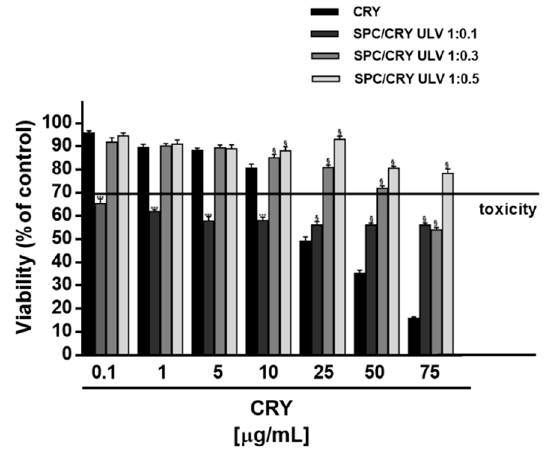
Figure 5. Cytotoxicity of SPC ULV differently loaded with CRY (1:0.1, 1:0.3 and 1:0.5 mol/mol) in MDA-MB-468 cells after 24 h incubation. *** p < 0.001 vs. CRY, denotes a statistically significant increase of cytotoxicity respect to pure CRY (ANOVA + multiple Dunnett’s comparison post-test). § p < 0.001 vs. CRY, denotes a statistically significant reduction respect to CRY cytotoxicity (ANOVA + multiple Dunnett’s comparison post-test). A cell viability lower than 70% respect to control (i.e.,